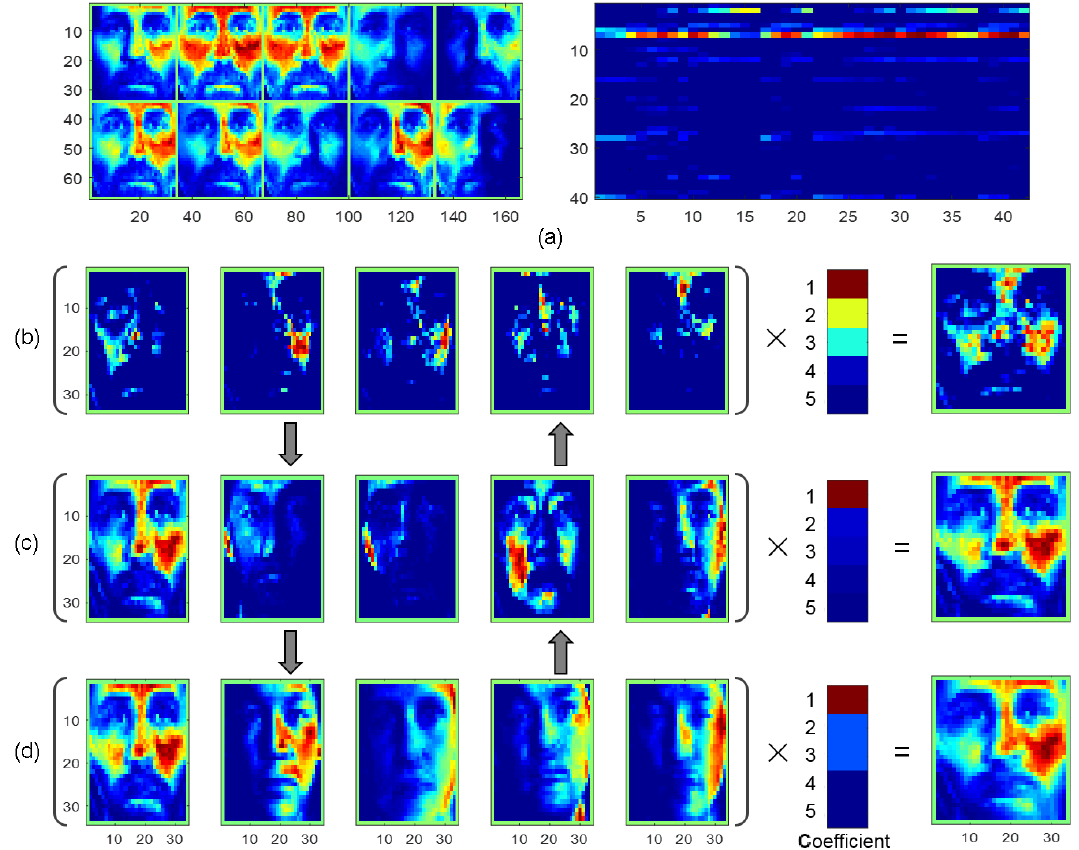
Fig. 8 Hierarchical feature interpretation by a linear SDNMF/L model with layer size = [193, 141, 40]. (a) 10 samples of class 36 and the representation matrix of class 36. Certain bases as well as corresponding coefficients in the first, second and third layers are shown in (b), (c), and (d), respectively. The horizontal and vertical coordinates indicate the indexs of each matrix (or